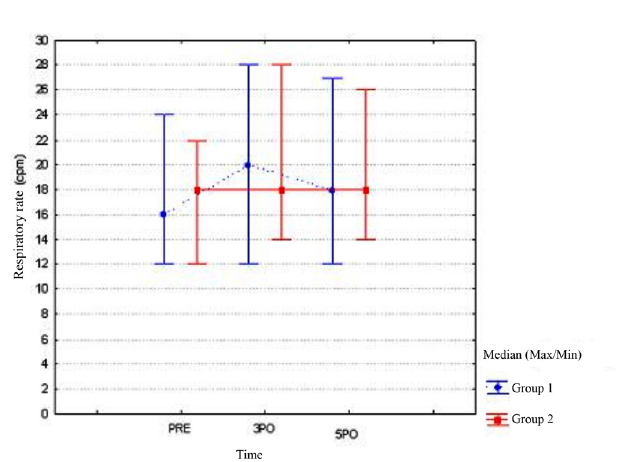
Fig. 6 - Median variable respiratory rate at different times of the operation of each group analyzed (with and without physical therapy preoperatively). Friedman test for comparison of moments in each group and Mann Whitney test to compare the groups at each time,